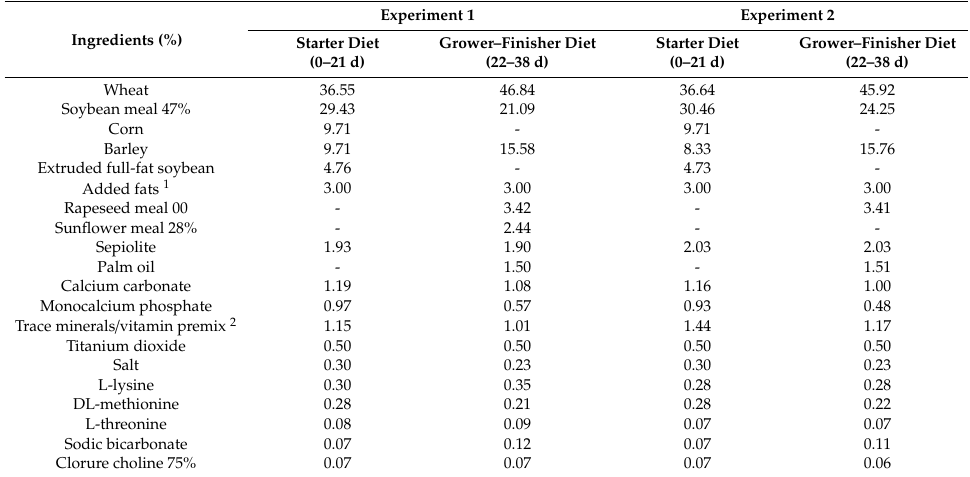
Table 1. Ingredient composition of the starter and grower–finisher broiler chicken diets on an as-fed basis (Experiments 1 and